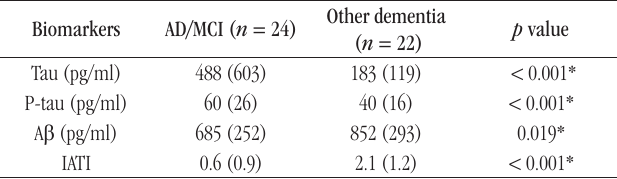
taBLE 2 − Comparison of Tau, P-tau and A β values and IATI in groups with AD/MCI e other dementia